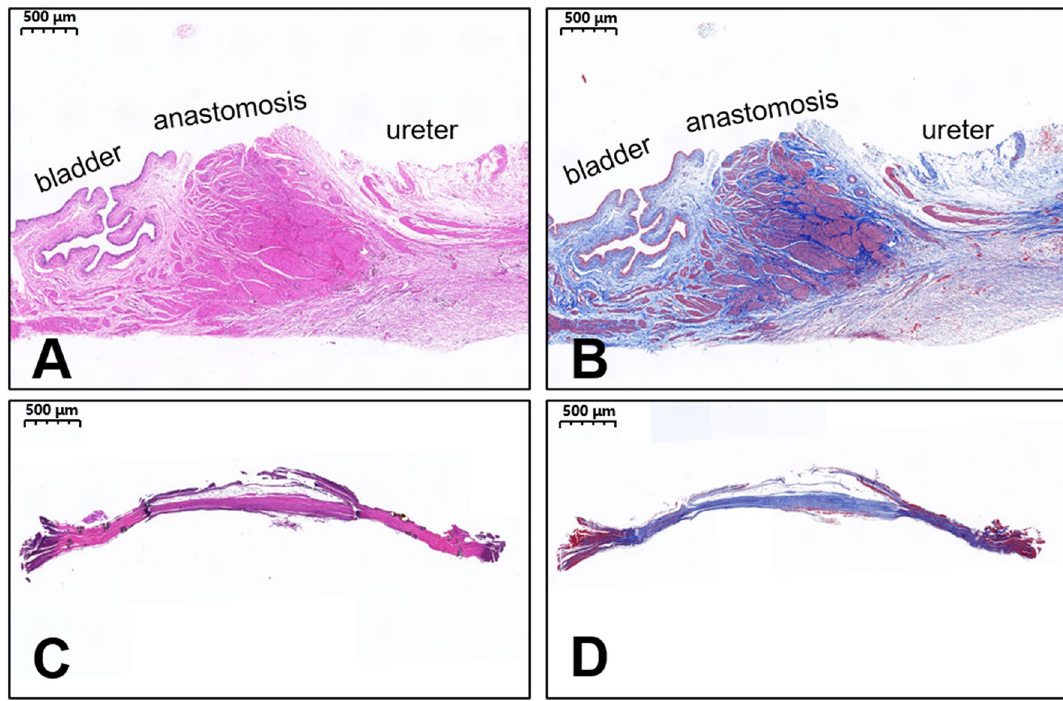
Figure 6. Histological images of the ureterovesical anastomosis. ( A ) HE staining, × 20 magnification; ( B ) Masson’s trichrome staining, × 20 magnification. Histological images of the necrotic tissue between the parent and daughter magnets. ( C ) HE staining, × 20 magnification; ( D ) Masson’s trichrome staining, × 20